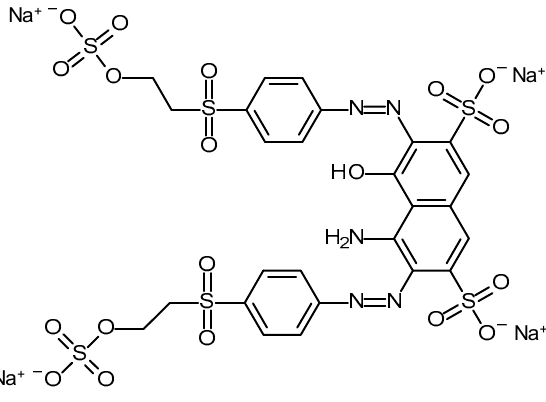
Figure 6. Chemical structure of Reactive Black 5.